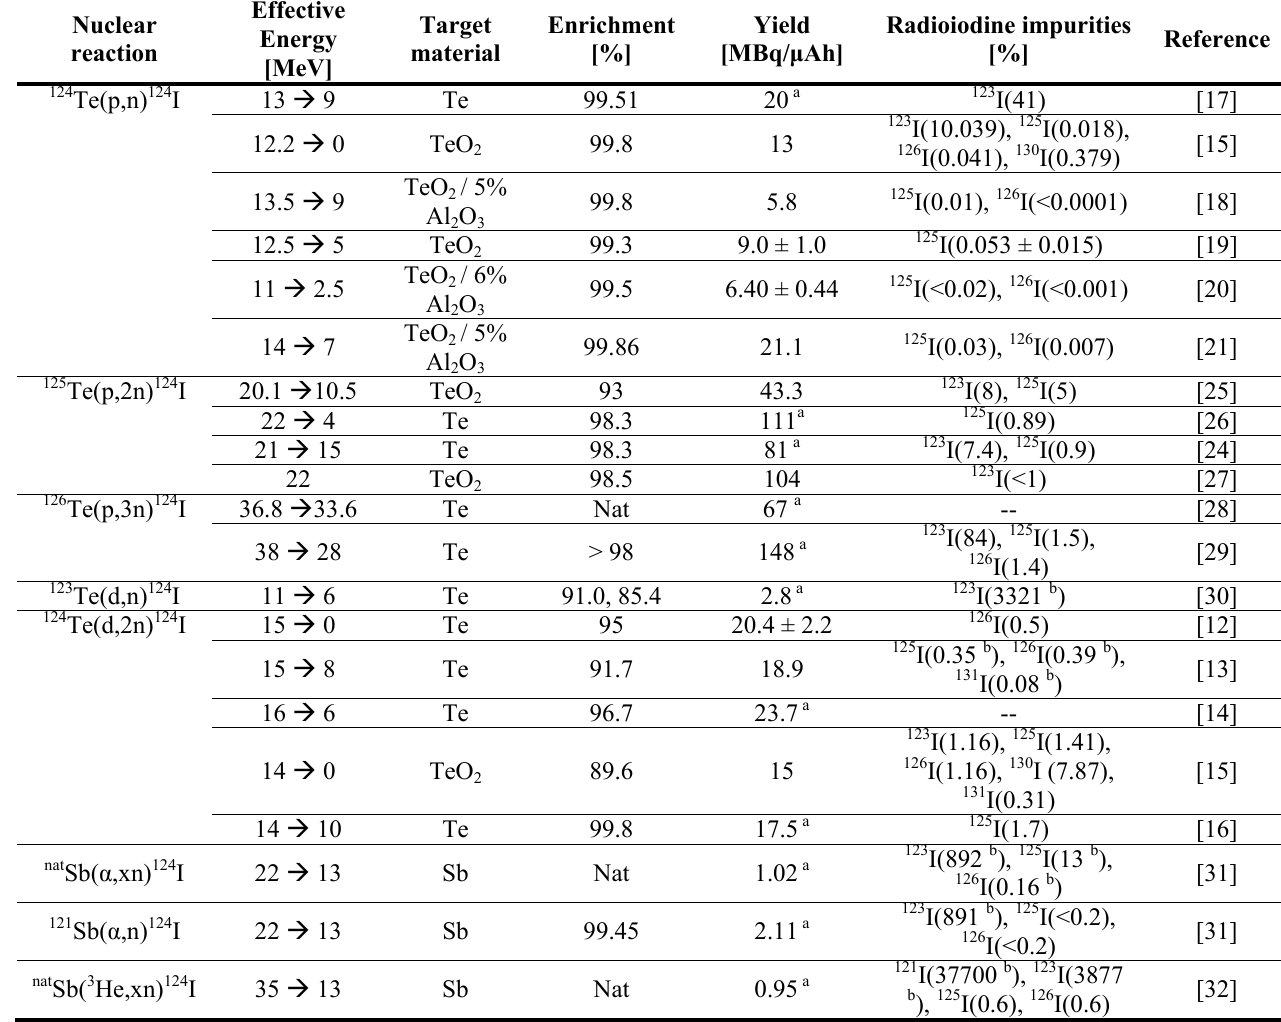
Table 1. Selection of published data on 124 I